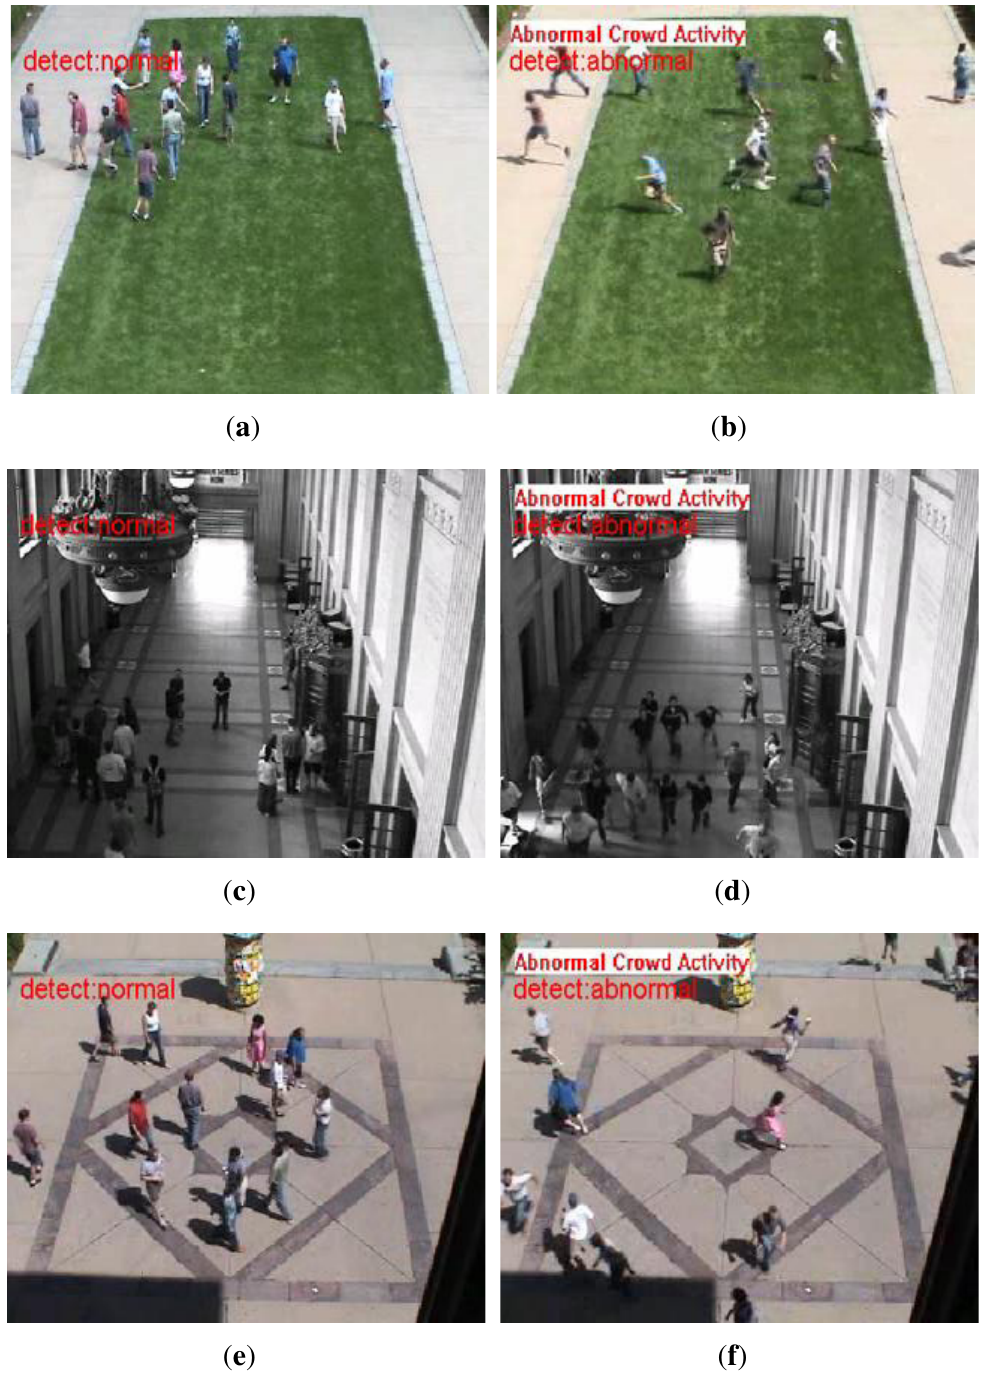
Figure 8. Detection results of the UMN scenes. Normal events are those where the individuals are walking; abnormal events are those where the individuals are running: ( a , c , e ) normal frames of lawn, indoor and plaza scene; ( b , d , f ) abnormal frames of lawn, indoor and plaza